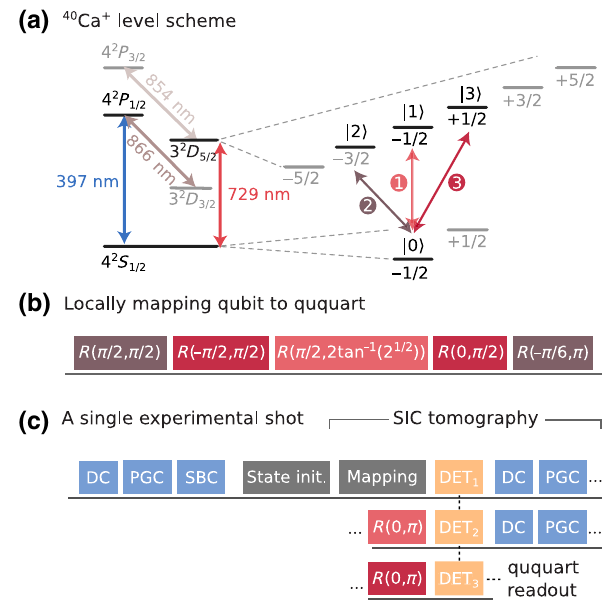
FIG. 2. Experimental implementation of SIC tomography from Figs. 1(b) and 1(d). (a) Level scheme of a 40 Ca + ion representing a qubit or ququart with important transitions marked: (blue) dipole transition for cooling and detection, (red) metastable quadrupole transition for encoding qubits and ququarts within the Zeeman submanifold, and (brown) additional transitions for repumping. (b) Gate sequence for locally map- ping the SIC POVM from Fig. 1(d) from qubit level to four orthogonal basis states of a ququart denoted in (a). This enables full readout of the SIC POVM in a single experimental shot by means of a four-outcome projective measurement. (c) Experi- mental realization of SIC tomography composed of cooling (DC, doppler cooling; PGC, polarization gradient cooling; SBC, side- band cooling), preparation of the state to be analyzed, mapping from qubit to ququart according to the SIC POVM, and finally the four-outcome projective measurement. For the latter, three sequential fluorescence detections (DETs) are required [17]; see Appendix A 1 for